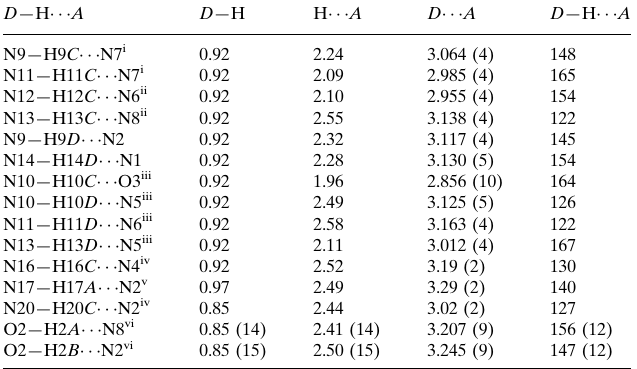
Hydrogen-bond geometry (A˚ , (cid:2)